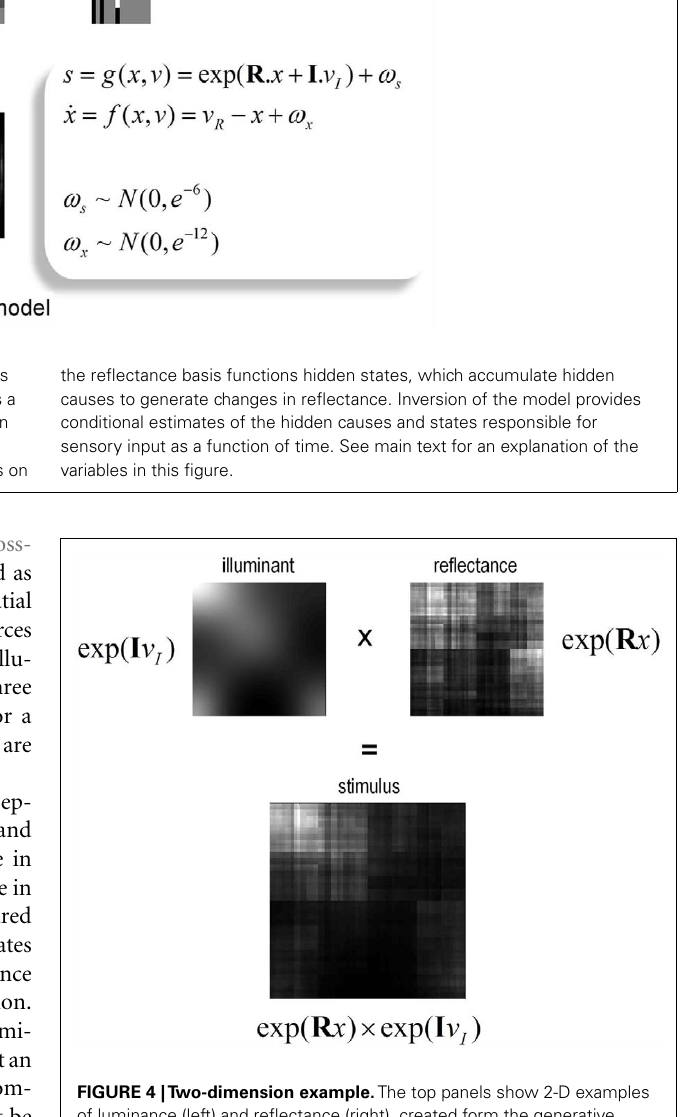
FIGURE 4 |Two-dimension example. The top panels show 2-D examples of luminance (left) and reflectance (right), created form the generative model.The resulting stimulus is the product of the two (bottom